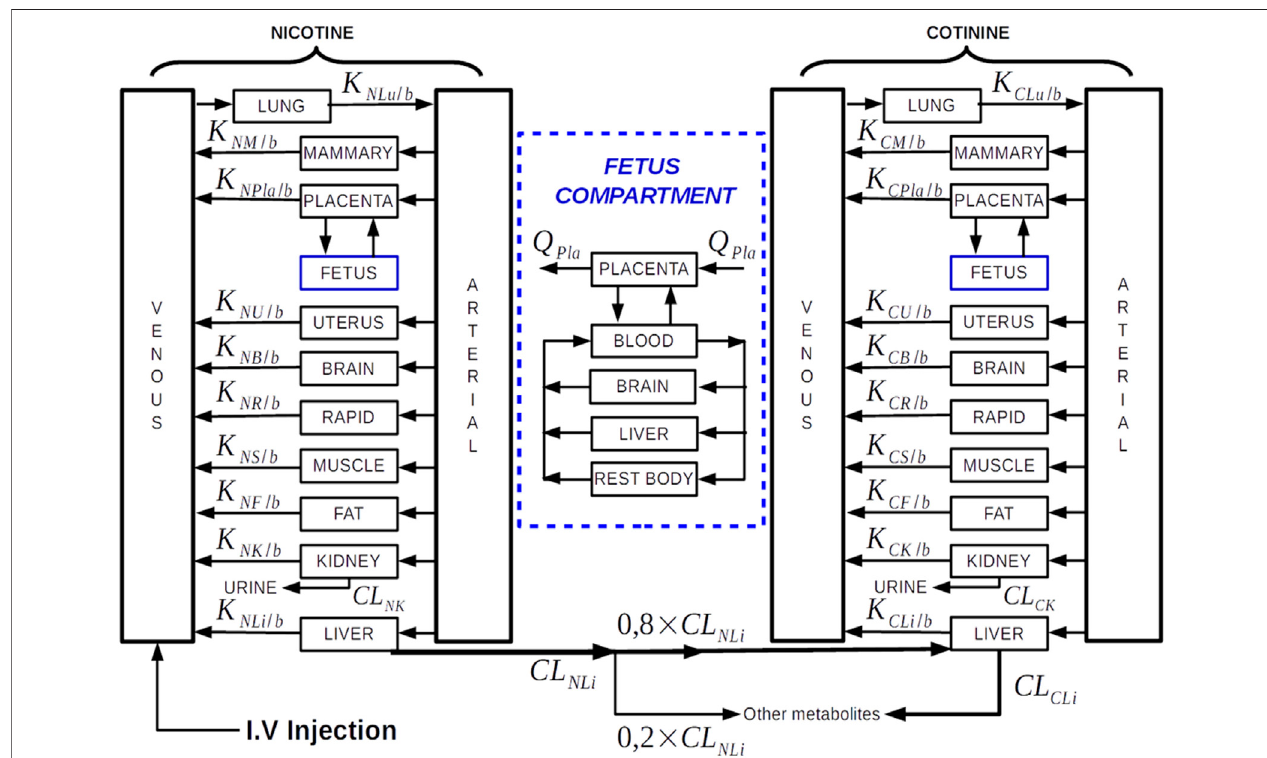
FIGURE1| DiagramoftheP-PBPKmodelstructurewithintravenousnicotineinjectionastheintakeroute.Theunderlyingdifferentialequationsandparametersare provided in Supplementary Material . Details of the fetus PBPK model are shown inside the blue compartment. Note, the “ Rapid ” compartment in the diagram corresponding to “ Vessel-rich Group ” compartment in the PBPK model of Robinson et al.